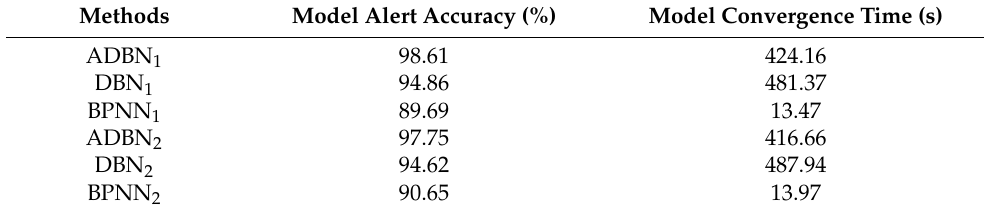
Table 4. Comparison of algorithm